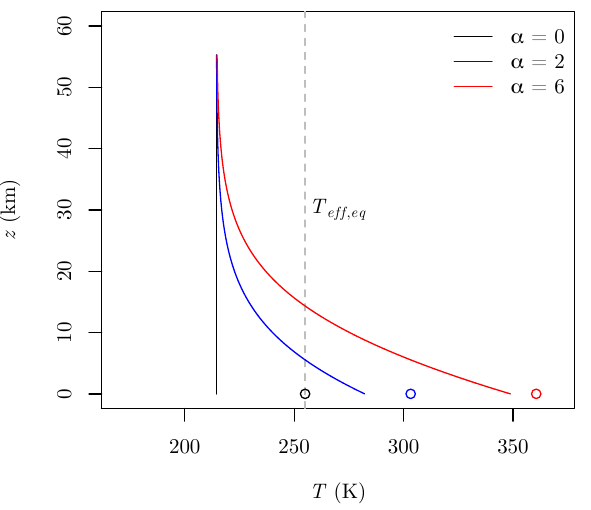
Figure 2. Vertical temperature profiles of a grey atmosphere in overall equilibrium for different absorptivities α . The latter cor- responds to α o in the window-grey model with β w = 0. T eff,eq = 255K. The circles at z = 0 denote the corresponding surface tem- peratures. Note that the vertical coordinate z is only approximate height, calculated from h with a constant scale height H = 8km such that h = 1 − e − z/H